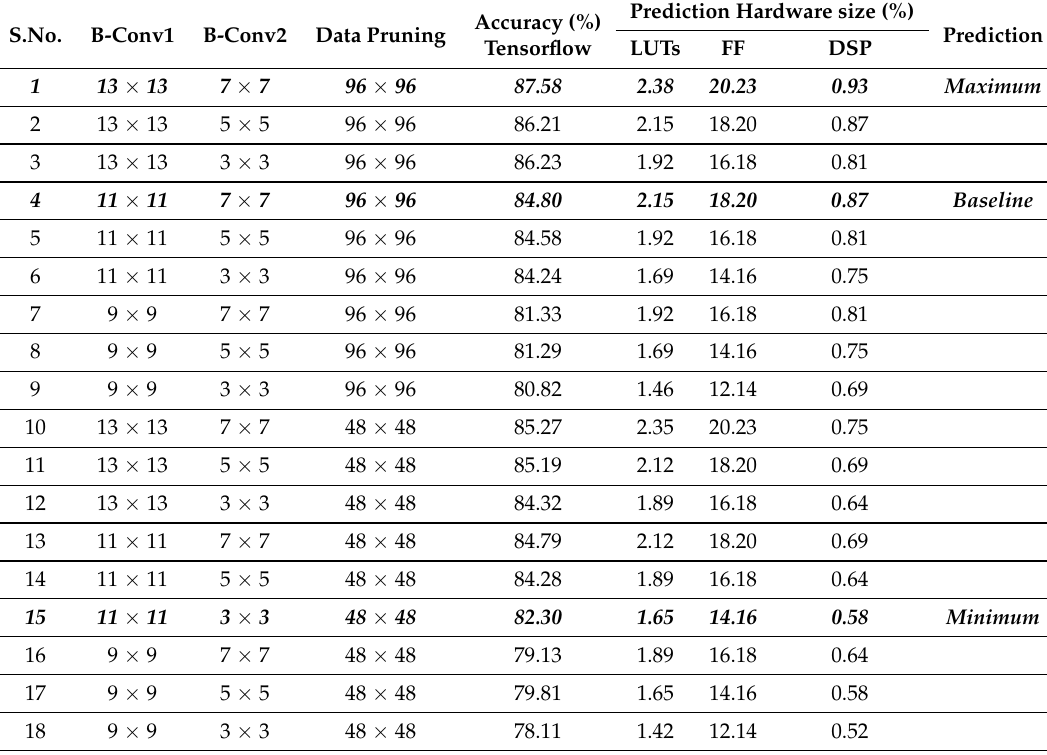
Table 3. Taguchi based forecast matrix of design of